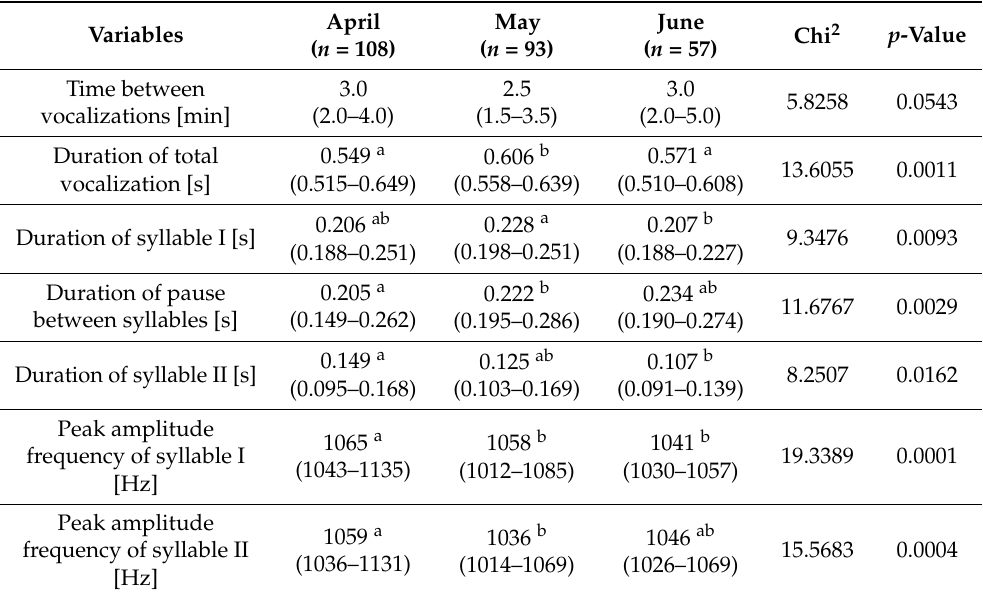
Table 2. The distribution of variables according to the month.